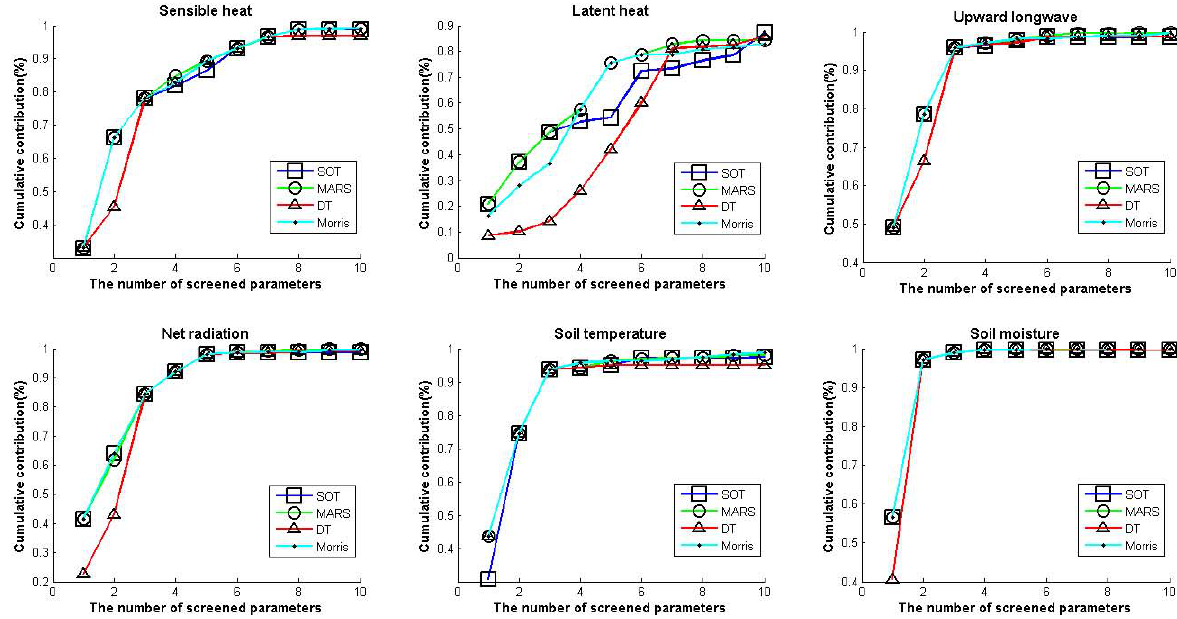
Fig. 13. The relationship between the number of screened parameters and cumulated relative importance for different sensitivity analysis